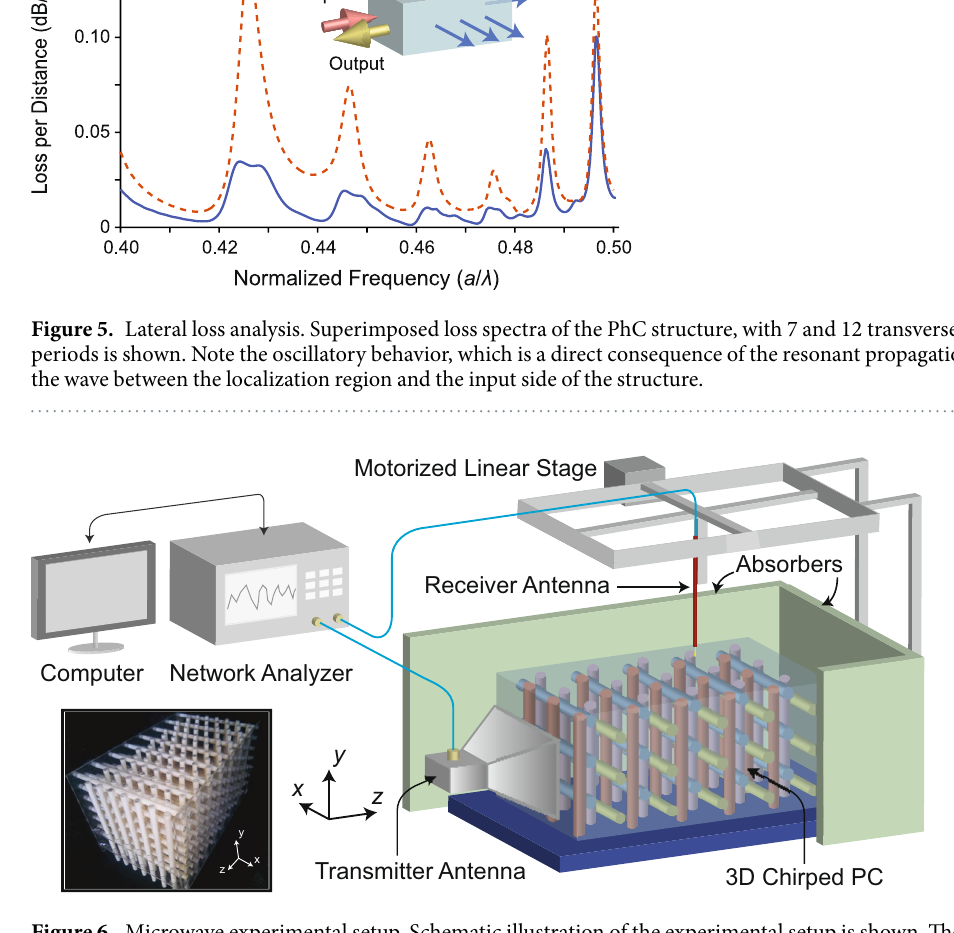
Figure 6. Microwave experimental setup. Schematic illustration of the experimental setup is shown. The lower left inset depicts the photographic view of the constructed woodpile